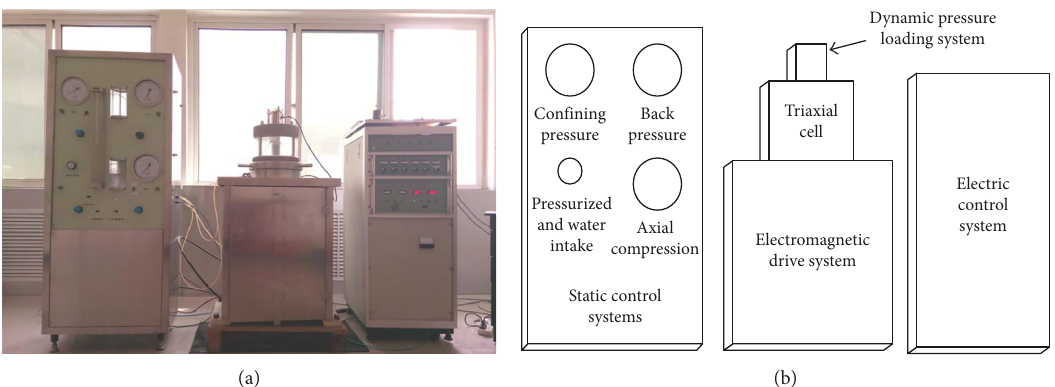
Figure 1: DDS-70 dynamic triaxial test apparatus: (a) view; (b) schematic diagram.